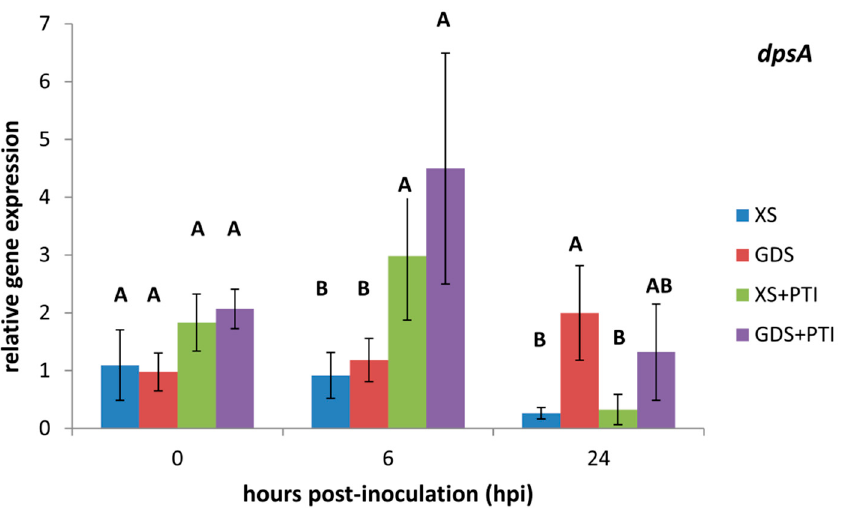
Figure 2. In planta expression of dpsA of X. euvesicatoria as affected by PTI and/or GDS. At 0 hpi, the plant leaves were injected with 10 8 cell mL − 1 X. euvesicatoria . PTI was initiated 24 h prior to X. euvesicatoria inoculation by injecting the same leaves with heat-killed P. syringae 61 hrcC . Leaf samples were taken at the indicated time points after X. euvesicatoria infections. To determine the relative gene expression, the measured target gene Ct values were normalized to those of the reference genes ( atpD and rpoB ), and the two relative gene expression values were averaged. Bars represent the mean ± standard deviations of two replicates. The letters above the columns indicate significantly different groups for the values belonging to the given sampling time. XS: susceptible plant, GDS: gds gene-carrying resistant plant, +PTI: PTI activated in the plant before X. euvesicatoria inoculation.